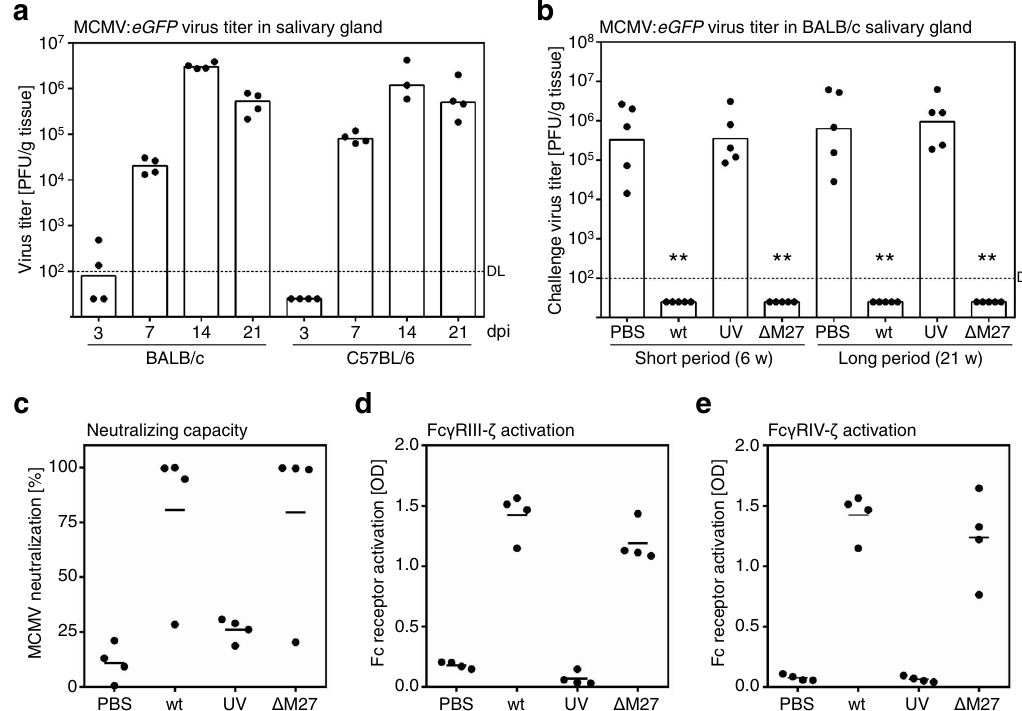
Fig. 7 Vaccination with Δ M27-MCMV protects adult mice from challenge infections. a C57BL/6 and BALB/c mice were infected i.p. with MCMV:eGFP. At 3, 7, 14, and 21 dpi, salivary glands were harvested and frozen ( n = 3-4 per group). The virus titers were determined from organ homogenates by plaque titration. b BALB/c mice were vaccinated with 2 × 10 5 PFU of wt-MCMV, Δ M27-MCMV, or UV-inactivated wt- MCMV. At 6 and 21 weeks post vaccination, mice were challenged with 2 × 10 5 PFU of MCMV:eGFP. At 21 days post-challenge infection, salivary glands were harvested and frozen. The MCMV:eGFP titers were determined from organ homogenates by plaque titration. All titrations were done in quadruplicate. Bars depict the geometric mean, dots show titers of individual mice ( n = 4-5 per group). DL detection limit. All vaccinated groups were compared to the corresponding control group by Kruskal – Wallis test corrected for multiple comparisons by controlling the false discovery rate. ** p value <0.01. *** p value <0.001. c – e Neutralizing antibody titers and Fc γ receptor-activating capacity were quanti fi ed from serum samples collected one week prior to the challenge infection (5 weeks after vaccination). The mean values as well as the values of individual mice are shown. Protection of vaccinated animals are shown in Fig. 7b. c In vitro neutralization assay. d Activation assay for mFc γ RIII. e Activation assay for mFc γ